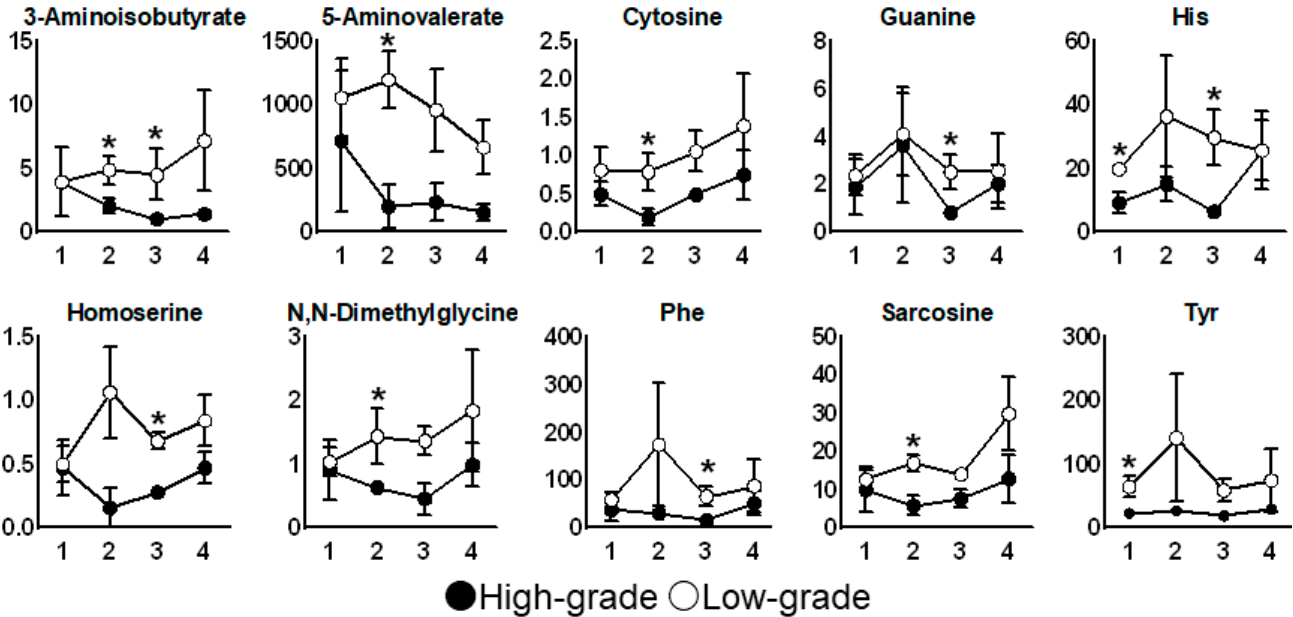
Figure 4. Time course of metabolites showing significant differences in their concentration (Mann–Whitney test) at at least one time-point between the low- (open circle) and high-grade (filled circle) oral mucositis group. The mean and standard errors are shown. * p < 0.05. The x -axis indicates the sampling point described in Figure 1. The y -axis indicates the concen- tration of each metabolite ( μ M).